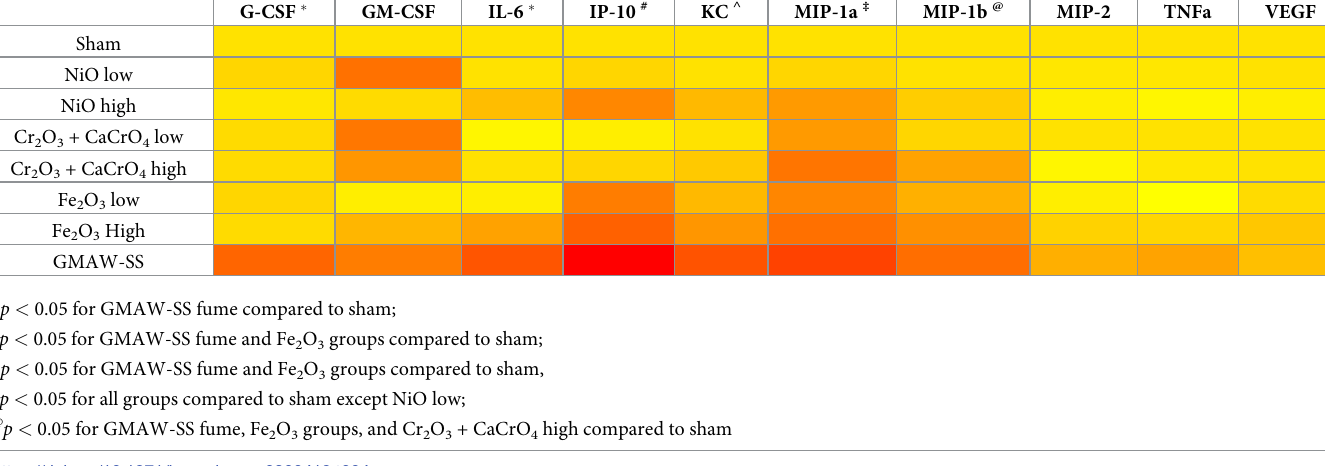
Table 4. BAL cytokine analysis at 28 days post-exposure to GMAW-SS fume or surrogate metal oxides. Color scheme of yellow-orange-red represent fold change from sham (darker red represents greatest